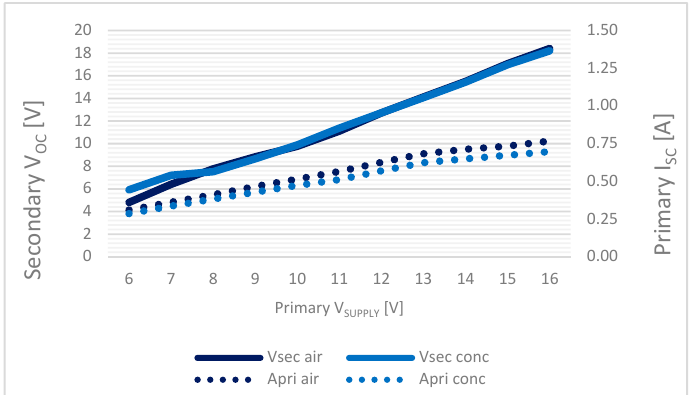
Figure 15. Inductive charging system characterization: secondary V OC and I SC in air and concrete